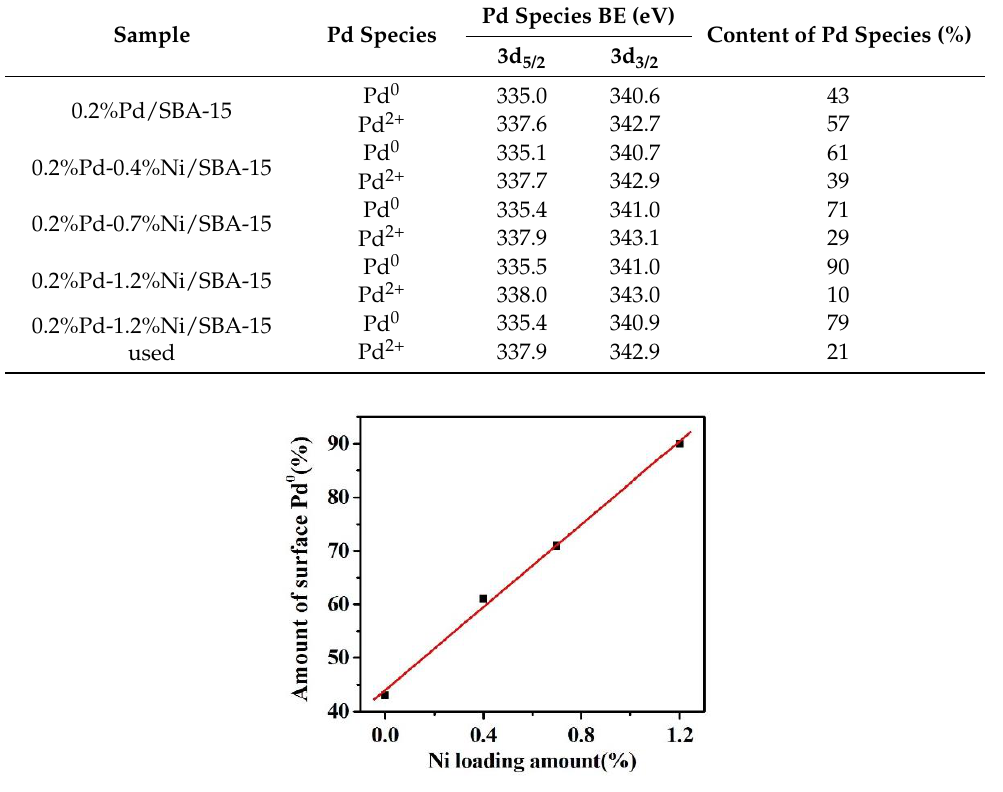
Figure 6. Relationship of the amount of surface Pd 0 with the Ni loading amount.